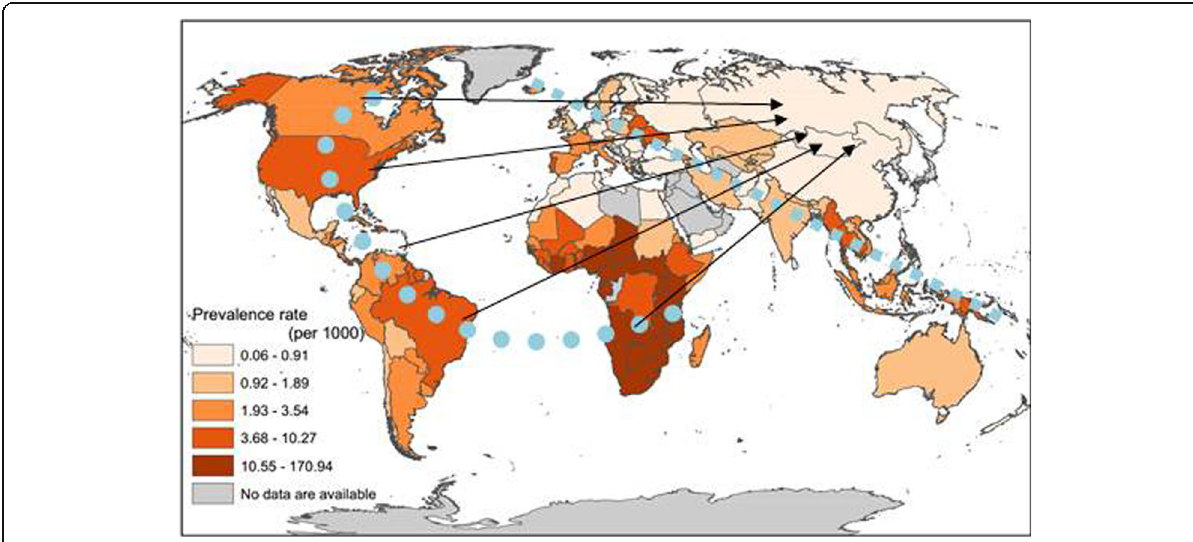
Fig. 1 Global patterns of the prevalence rates (1/1000 population) of persons living with HIV (PLWH), 2011-2015 (Source: Created with data from UNAIDS and other sources)